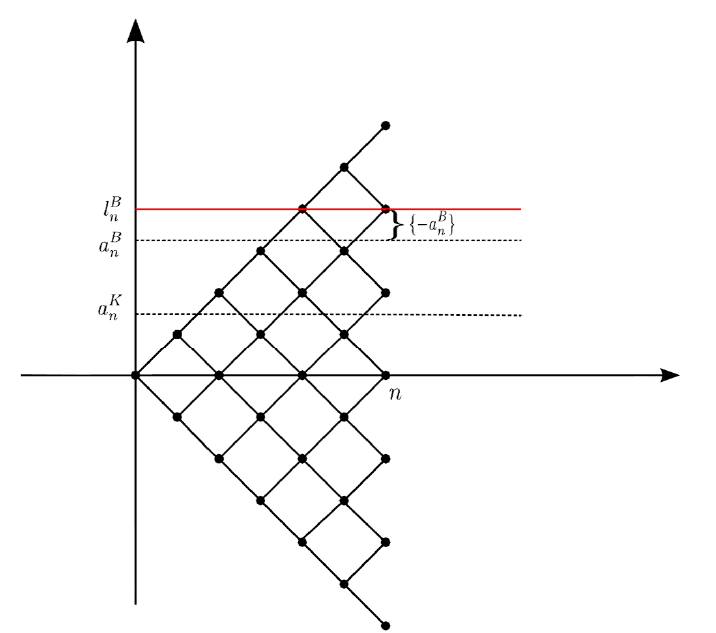
Figure 4. Dynamics of ∑ n